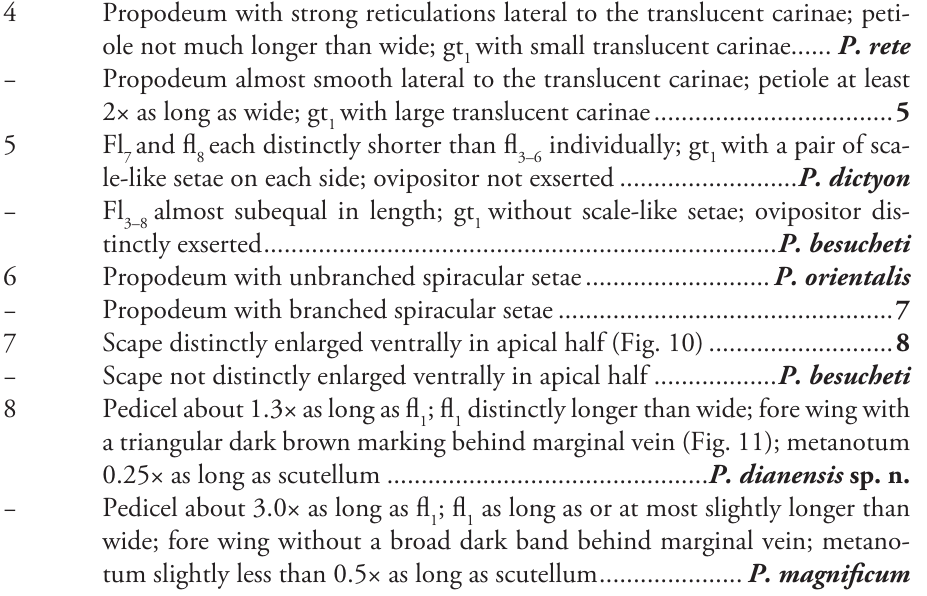
Pedicel about 1.3× as long as fl Pedicel about 3.0× as long as fl